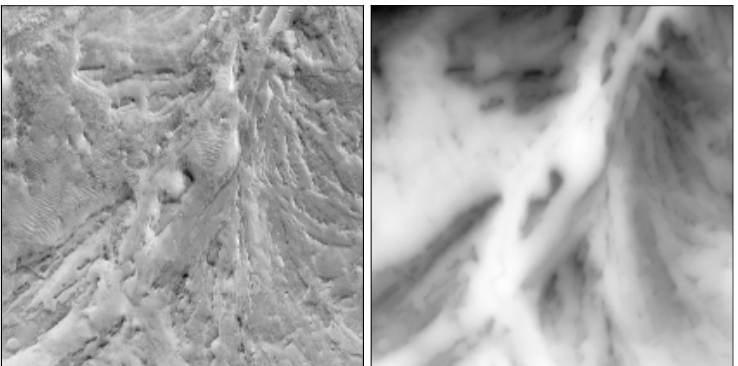
Figure 6. The orthomosaic ( left ) and corresponding DEM ( right ) of the Apollo 17 landing site, with a resolution of 0.5 m per